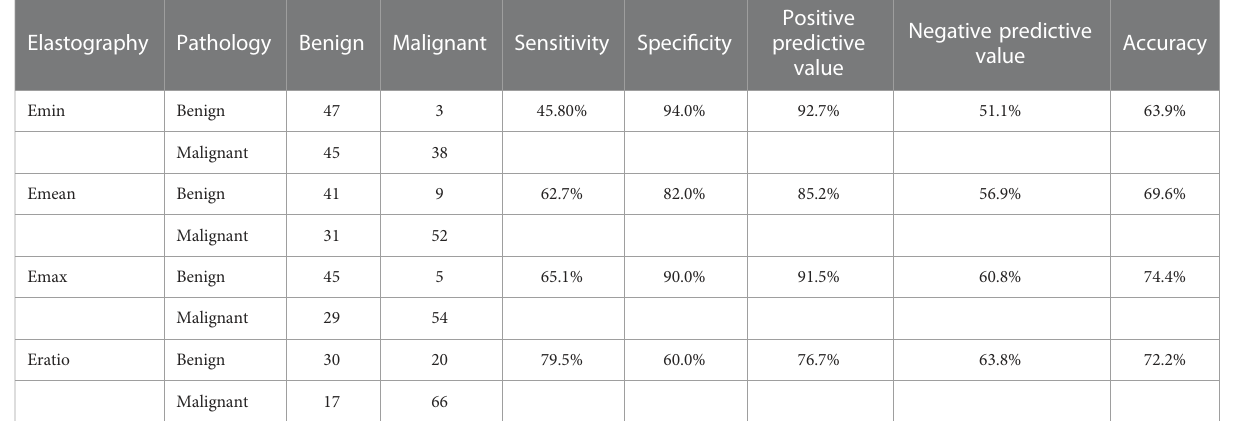
TABLE 3 Diagnostic performance of Emin, Emean, Emax, and Eratio in differentiating benign and malignant nodules.